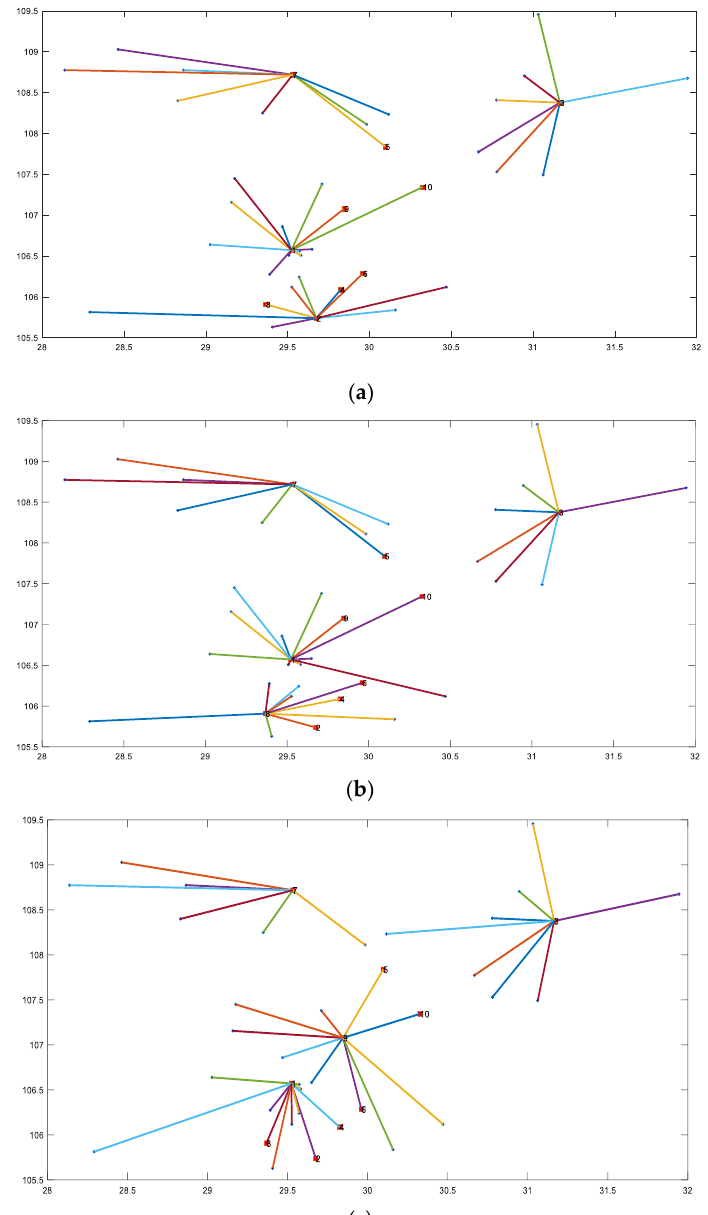
Figure 3. ( a ) Secondary clustering of scheme 1; ( b ) secondary clustering of scheme 2; ( c ) secondary clustering of scheme 3.